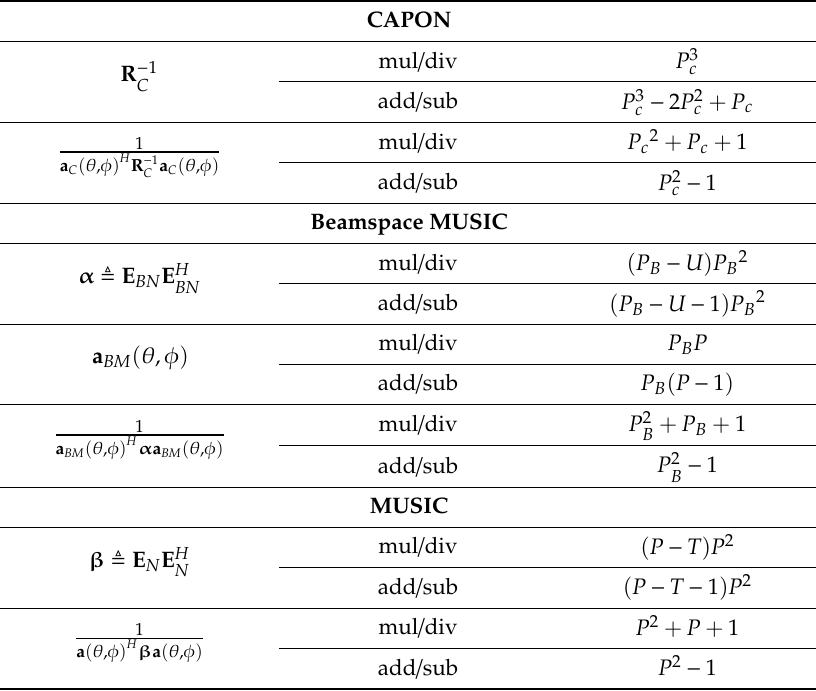
Table 6. Computational complexity of the three